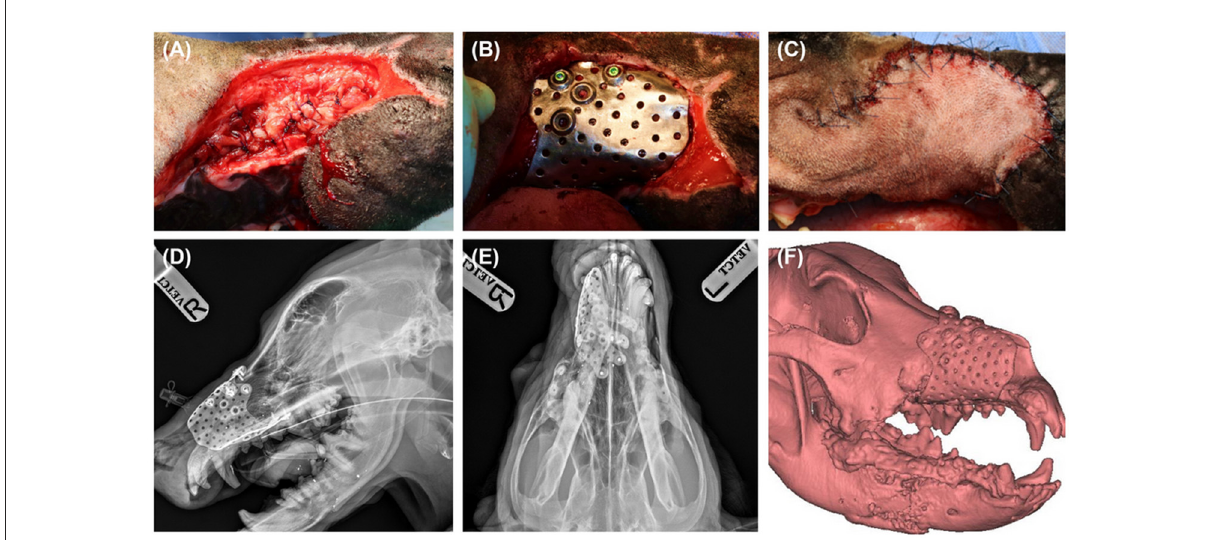
FIGURE5 Sublingual mucosa graft was applied and undermined soft tissue around the defect was sutured over the graft to secure reconstructed nasal cavity (A) . Titanium PSI was seated percutaneously, and screws were placed under fluoroscopic guidance (B) . PSI was fully covered with angularis oris flap (C) . Post operative radiographs, lateral (D) and dorsoventral (E) view, and 3D reconstruction of post operative CT scan revealed precise fit of the implant (F) .